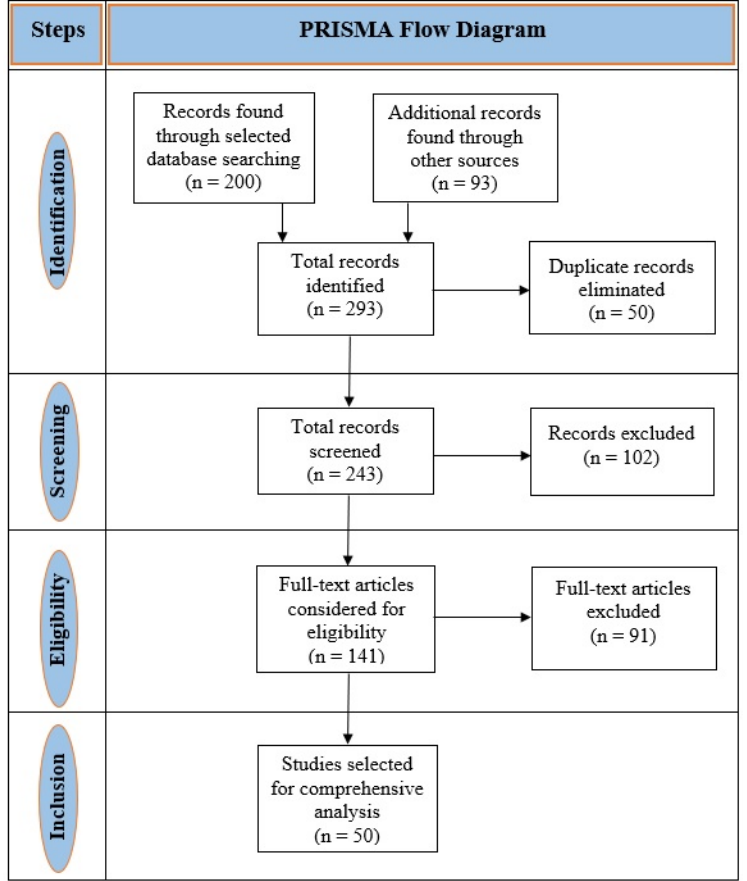
Figure 1. PRISMA flow diagram for searching results.